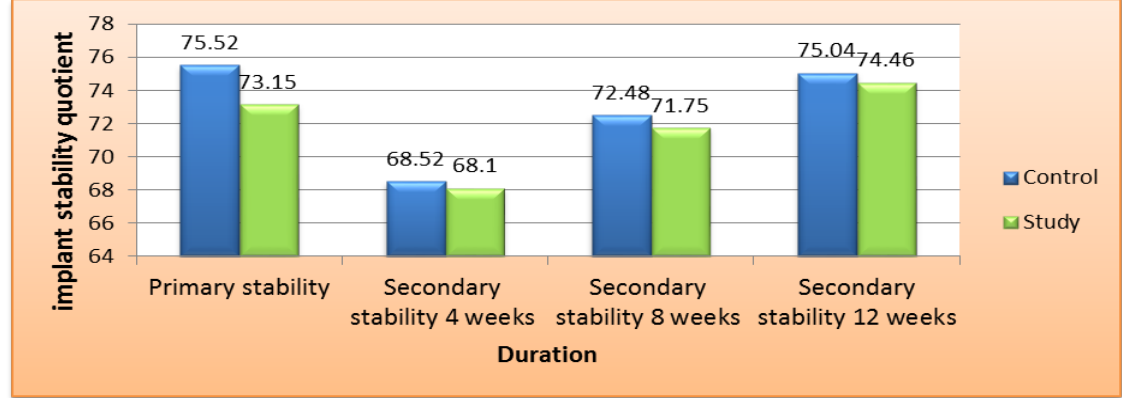
Figure (6): Comparison of the changes in mean of ISQ in both control and study group throughout the healing periods after